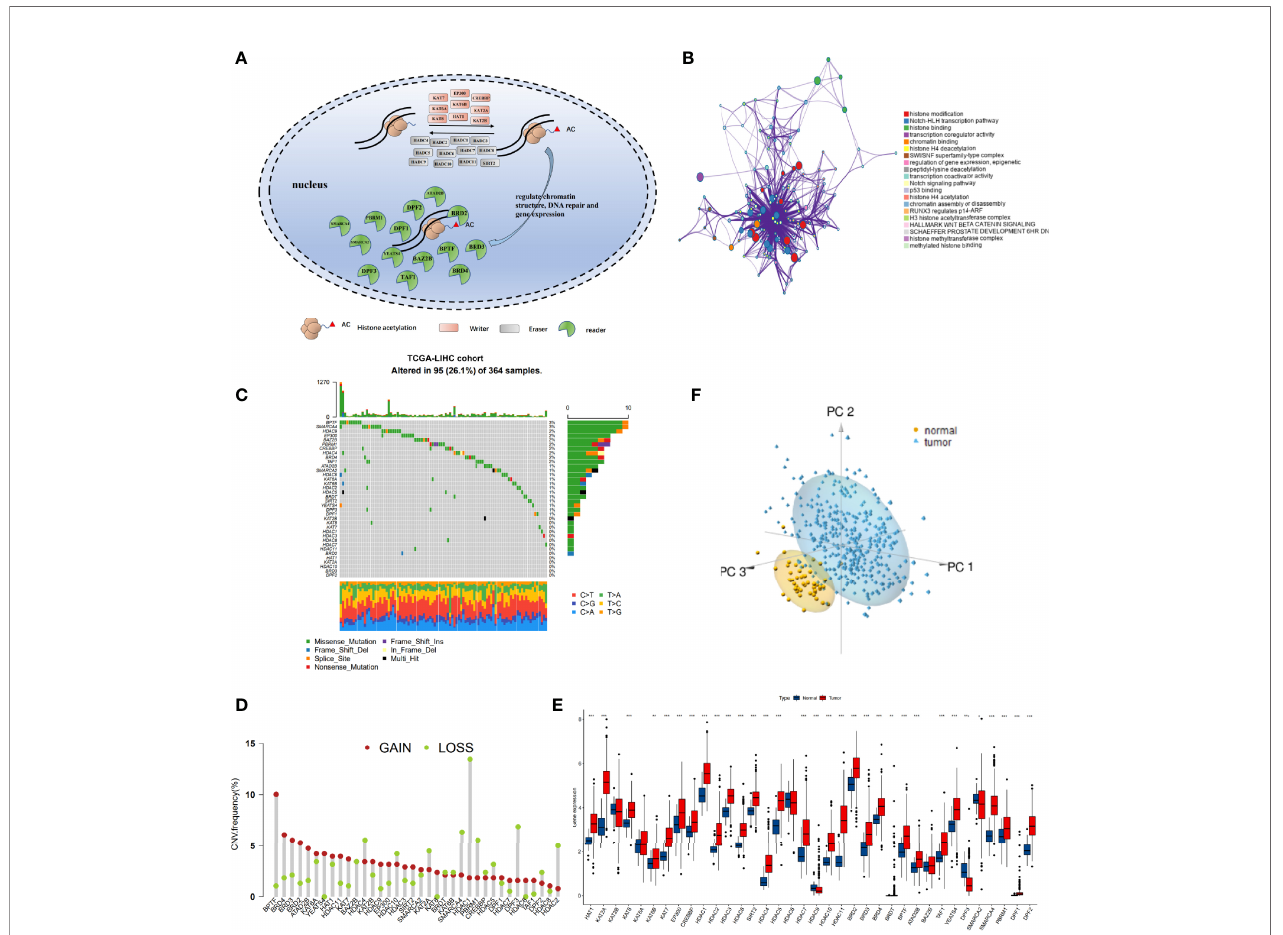
FIGURE 1 | The landscape of genetic alterations of histone acetylation regulators in hepatocellular carcinoma (HCC). (A) Summary of the dynamic reversible process of histone acetylation modi fi cation mediated by regulators ( “ writers, ” “ erasers, ” and “ readers ” ) and their biological functions. (B) Functional annotations of 36 regulators analyzed by the Metascape enrichment tool. Cluster annotations are shown in the color code. (C) The mutation frequency of 36 histone acetylation regulators in TCGA-LIHC cohort. Each column represents individual patients. The barplot on top shows TMB, and the numbers on the right display the mutation frequency of each regulator. The barplot on the right shows the proportion of each variation type. The stacked barplot on the bottom displays the fraction of conversions in each sample. (D) The copy number variation (CNV) frequency of histone acetylation regulators in TCGA-LIHC was prevalent. The column represents the alteration frequency. The deletion frequency is a light-green dot; the ampli fi cation frequency is a crimson dot. (E) Boxplot shows the expression of the 36 histone acetylation regulators between tumor and normal tissues in the TCGA-LIHC cohort. Tumor: red; Normal: blue. (* P < 0.05, ** P < 0.01, *** P < 0.001). (F) Principal component analysis of the 36 histone acetylation regulators to distinguish tumors from normal samples in TCGA-LIHC. Tumor: pale blue; normal: